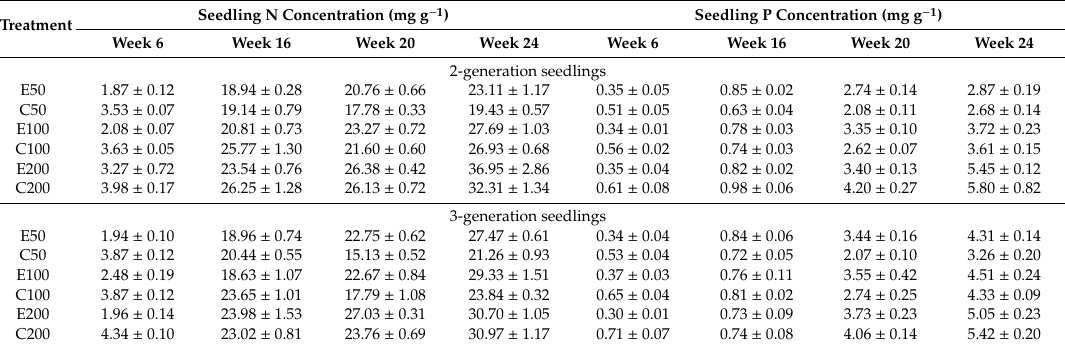
Table 2. Nitrogen (N) and phosphorus (P) concentrations in 2-generation and 3-generation Chinese fir seedlings under conventional and exponential fertilization regimes with increasing fertilization levels.